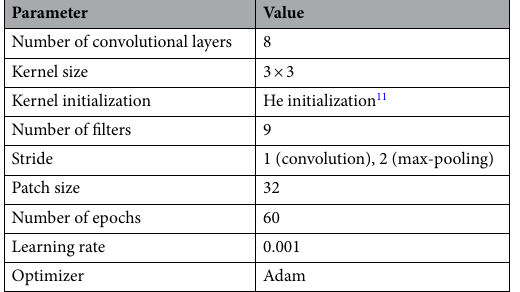
Table 2. Optimal parameters of our deep learning